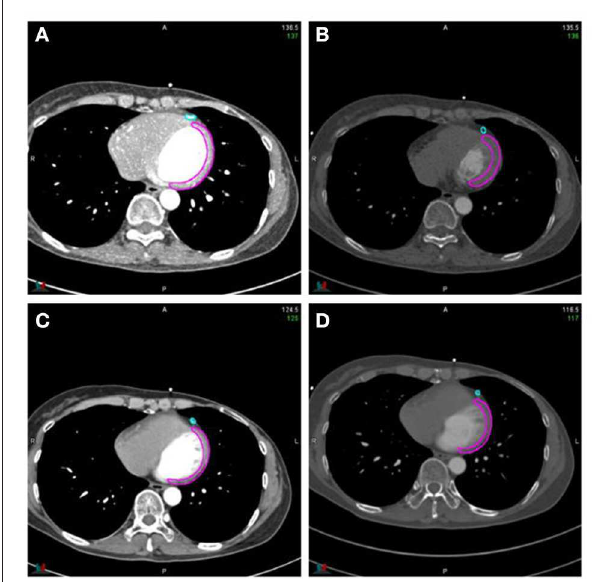
FIGURE 1 | Reconstruction sketch. (A) MIP; (B) MinIP; (C) AIP; (D)